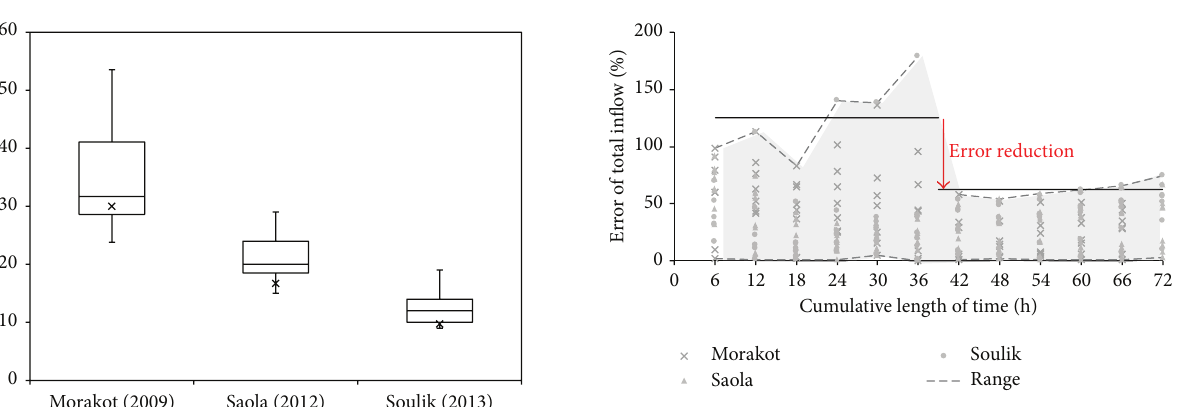
Figure 9: The box-percentile plots of MAE for the comparison of ensemble-mean (cross make) and all members (box percentile).